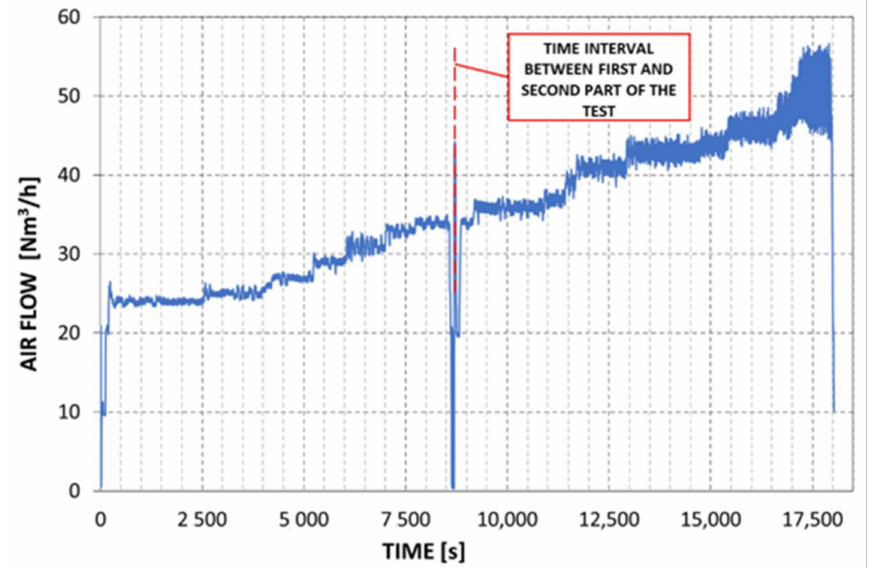
Figure 7. Plot over time of the booster driving-air flow rate during the test with hydrogen booster running at 44 cycles per